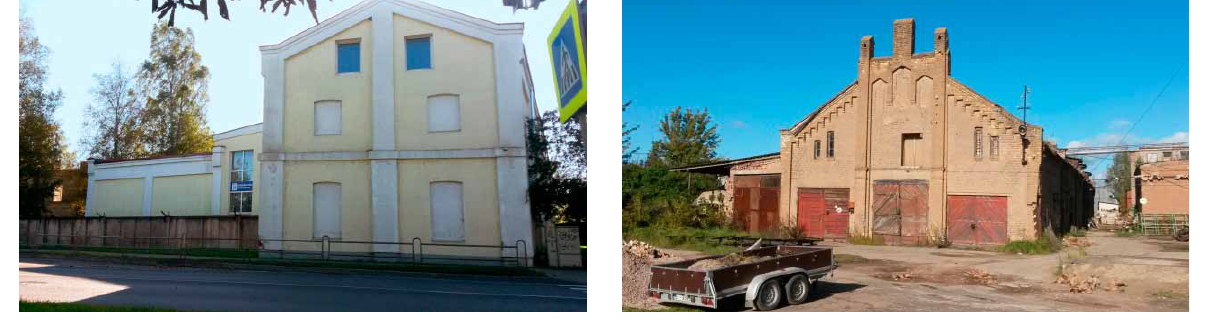
fig. 3. old M. Grebner wax cloth factory (end of the 19 th century) fig. 4. old leather factory (80s of the 19 th century)